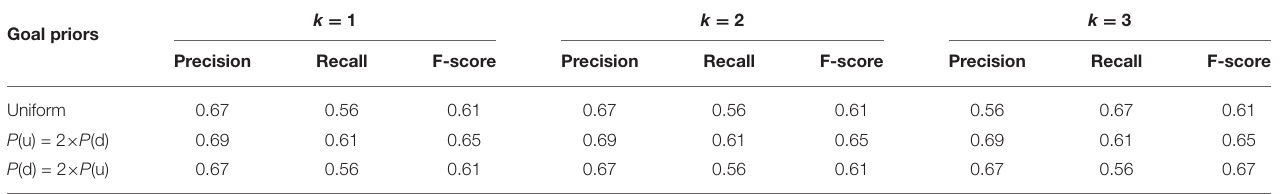
TABLE 11 | Precision, Recall, and F-scores for solving the Human-aware Intervention problem as a Plan Recognition problem with the Plan Recognition as Planning algorithm (Ramırez and Geffner, 2010). k = 1 k = 2 k = 3 Goal priors Precision Recall F-score Precision Recall F-score Precision Recall F-score Uniform 0.67